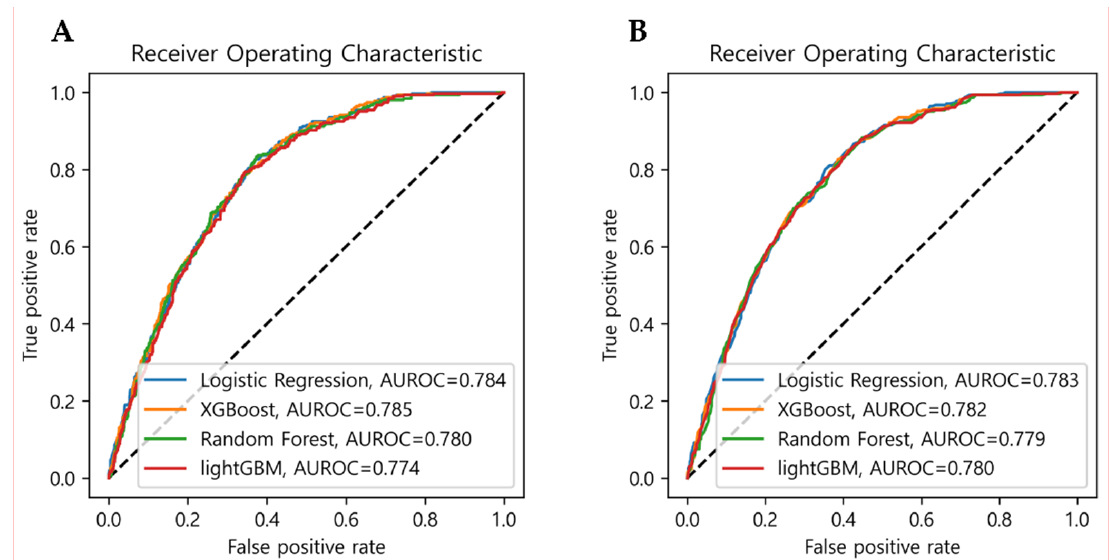
Figure 1. Comparison of the AUROC of the four models. Variables were selected ( A ) using backward elimination based on logistic regression and ( B ) using permutation importance based on random forest. Table 4. Summary of the predictive performance of each prediction model.